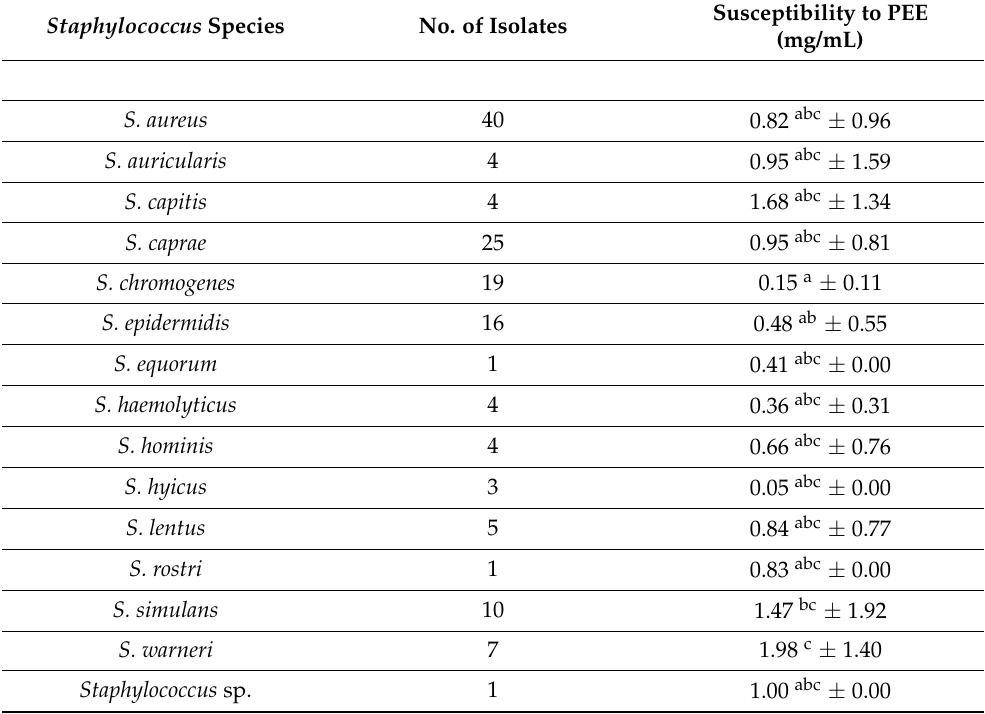
Data are shown as means ± standard deviation. Distinct lowercase letters (a–c) represent significantly different means ( p <